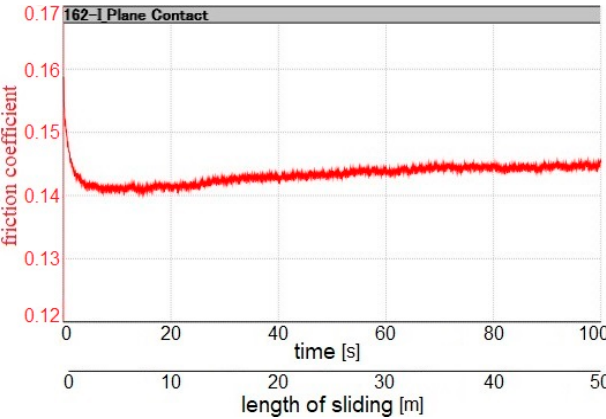
Figure 7. Dependence of the friction coefficient on the length of sliding for the 162-I sample surface.